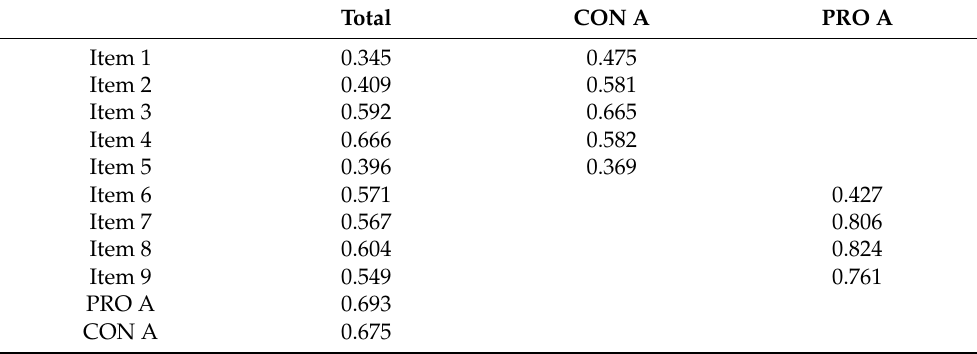
Table 6. Corrected item–test